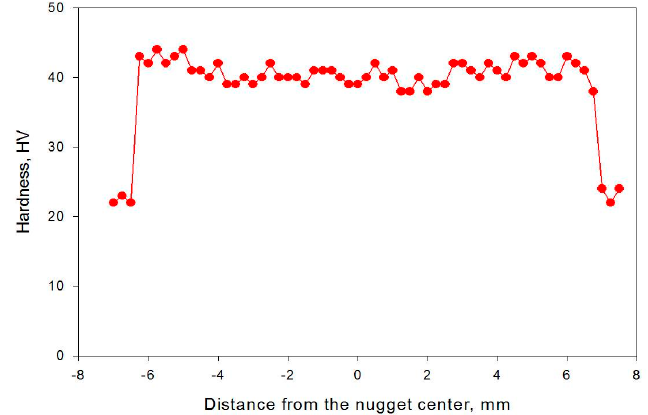
Figure 11. Hardness distribution in the horizontal section of the Fe 3 O 4 -nugget zone fabricated by triple FSP passes at a rotation speed of 1500 rpm.